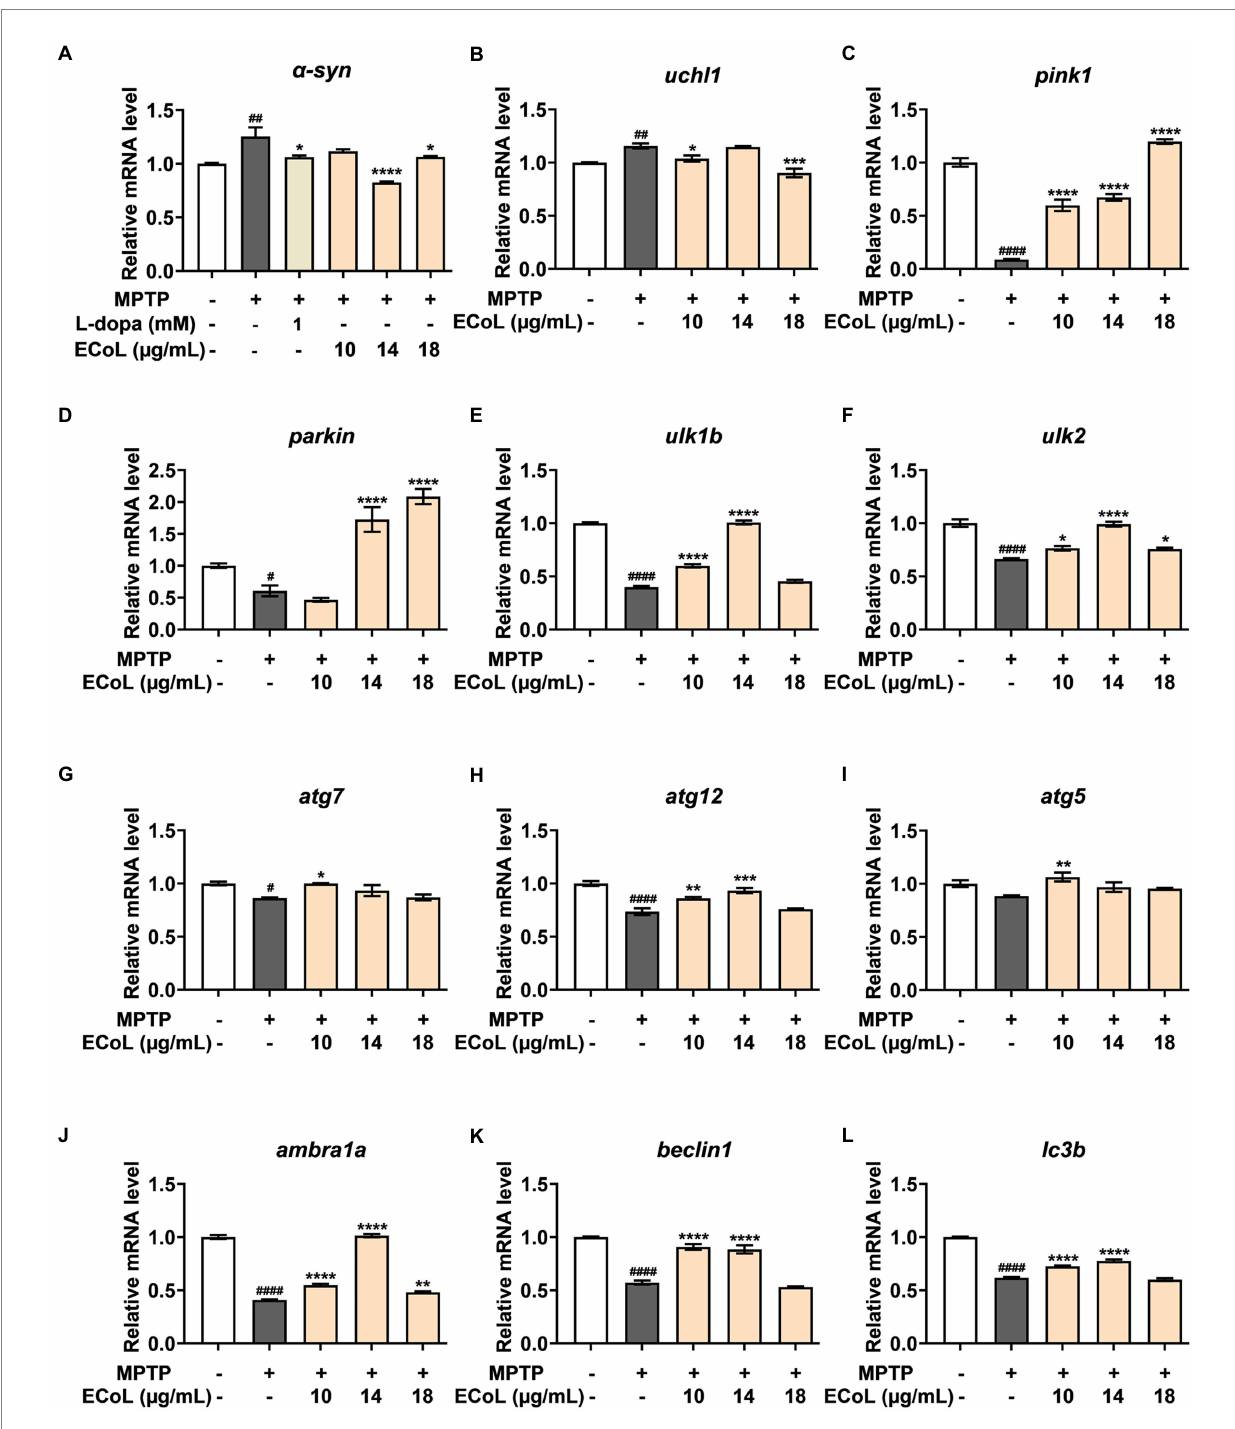
FIGURE 7 The mRNA expression levels of genes involved in autophagy. The expressions of α -syn (A) , uchl1 (B) , pink1 (C) , parkin (D) , ulk1b (E) , ulk2 (F) , atg7 (G) , atg12 (H) , atg5 (I) , ambra1a (J) , beclin1 (K) , and lc3b (L) after ECoL co-treatments. Data were represented as mean ± SEM, n = 3, and statistically analyzed by one-way ANOVA followed by Duncan test. # p < 0.05, ## p < 0.01, #### p < 0.0001 vs. Control; *p < 0.05, **p < 0.01, ***p < 0.001, ****p < 0.0001 vs.